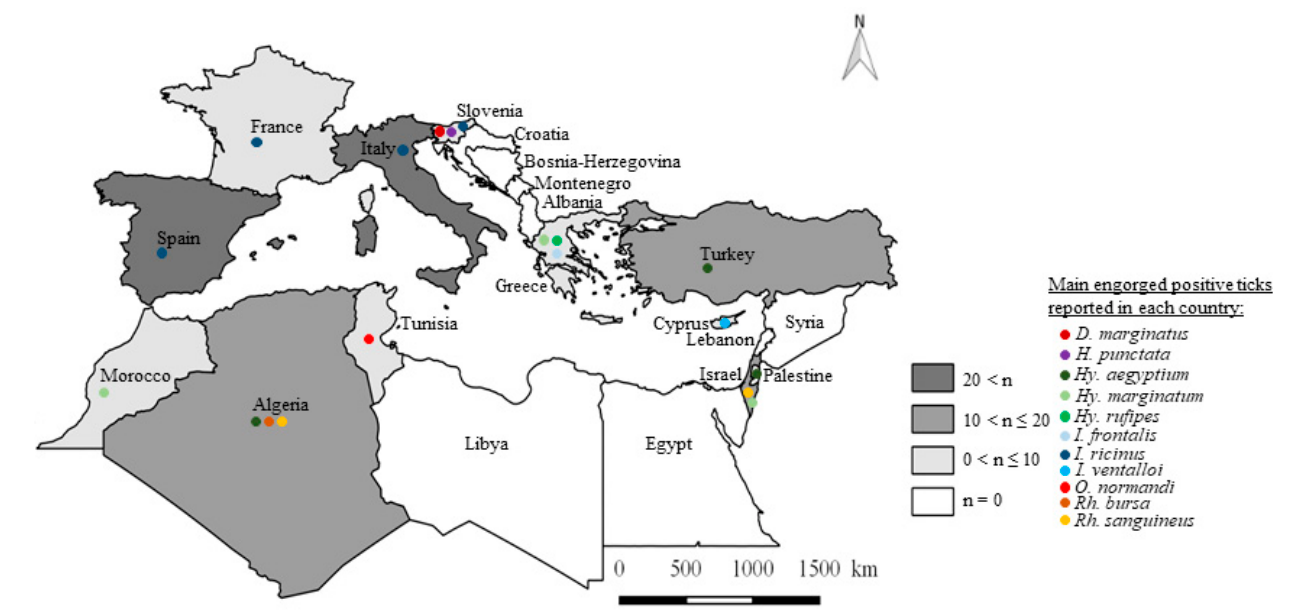
Figure 3. Distribution of main TBP-positive engorged tick species in Mediterranean Rim countries (n = number of TBP-positive engorged tick species by country).